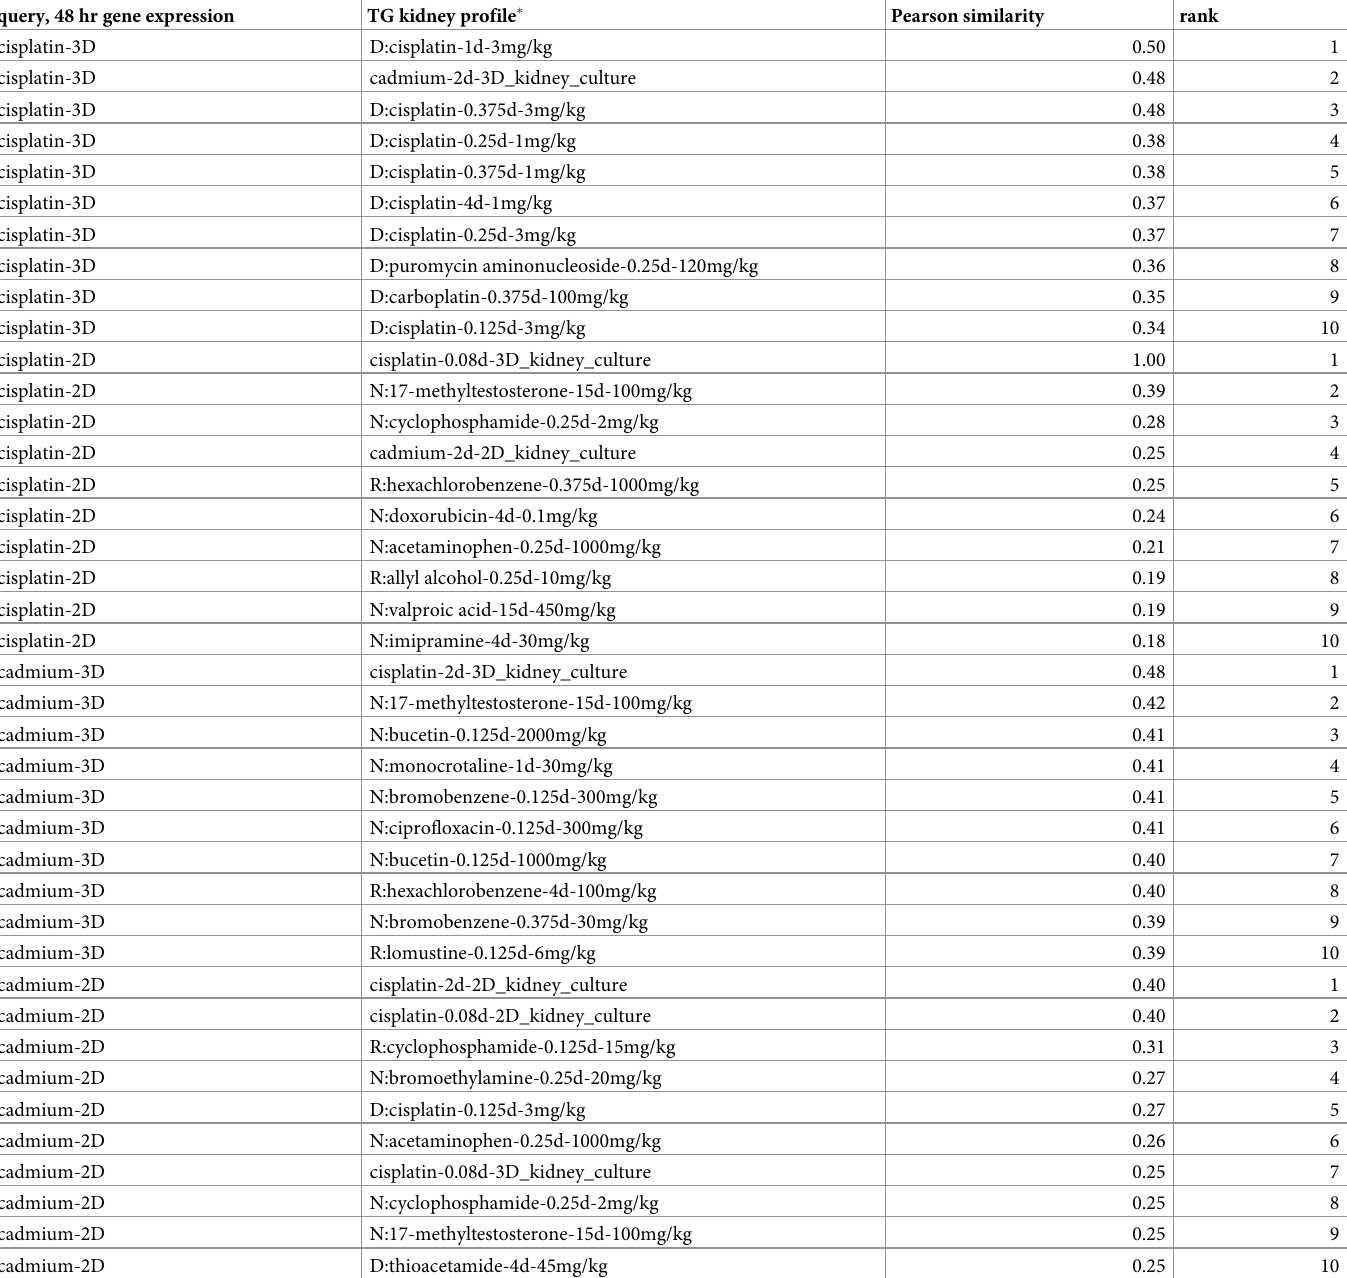
Table 4. Most similar rat kidney profiles to 2D and 3D RPTEC-TERT1 (monolayer vs. tubuloid) obtained from TXG-MAPr